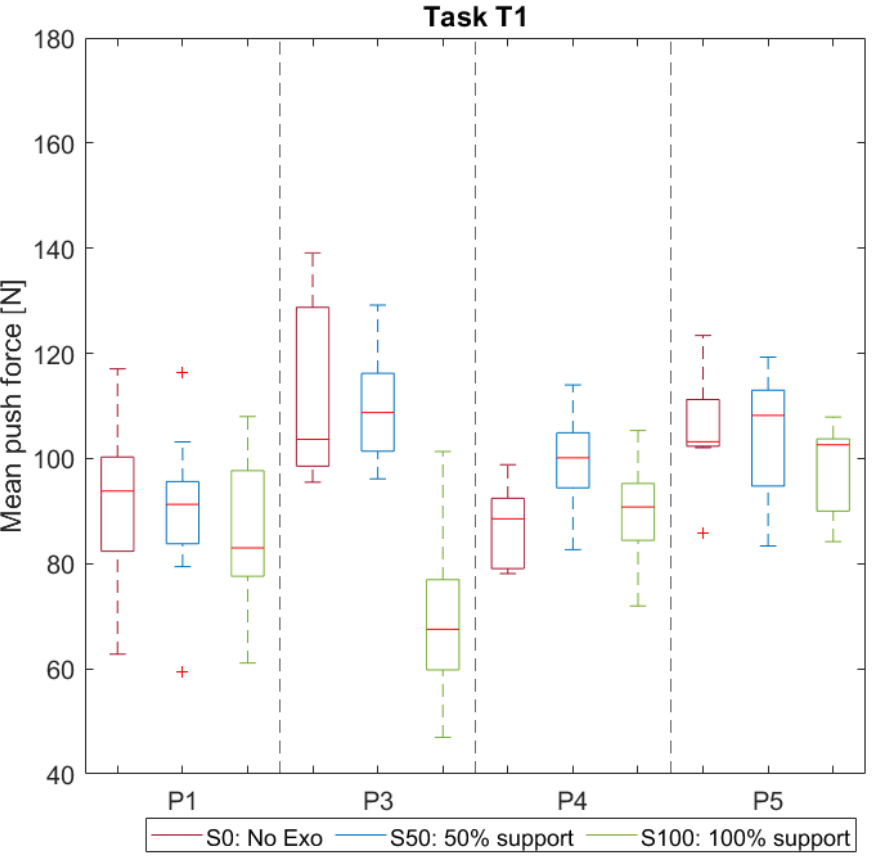
Figure 6. Mean push force of ten cycles for task T1 during the screw phase with all three support conditions (S0, S50, S100) of participants P1, P3, P4, and P5. The boxes represent the interquartile range (IQR). The length of whiskers is IQR*1.5. Outliers (>IQR*1.5).